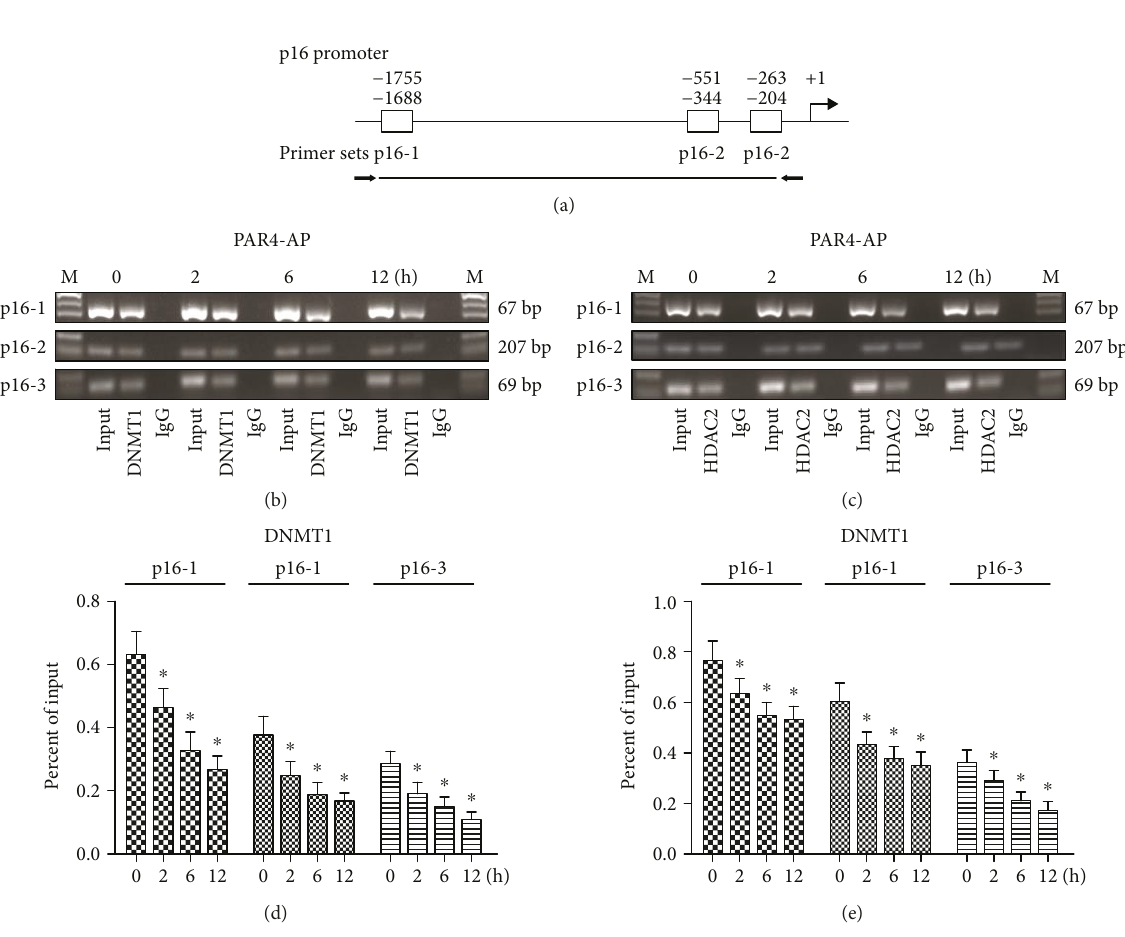
Figure 3: PAR4-AP suppressed DNMT1 and HDAC2 enrichments on the p16 promoter in ESCC cells. (a) Schematic representation of the p16 promoter region. P16-1, p16-2, and p16-3 indicate the locations of primers on the p16 promoter. (b, c) ChIP assays were performed for the p16 promoter in ESCC cells using antibodies to DNMT1 and HDAC2 after treatment of PAR4-AP at 2, 6, and 12 h. Normal rabbit IgG served as a negative control, and input chromatin (samples without immunoprecipitation (IP)) served as a positive control. (d, e) ChIP-qPCR assays to evaluate DNMT1 and HDAC2 enrichments in the p16 promoter region of ESCC cells with treatment of PAR4-AP at 2, 6, and 12h. The data are expressed as the mean ± SEM ( n = 3 ). ∗ P < 0 05 versus